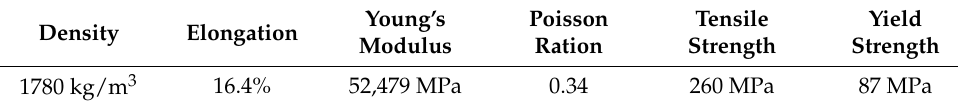
Table 3. Material properties of AZ31B used for Abaqus